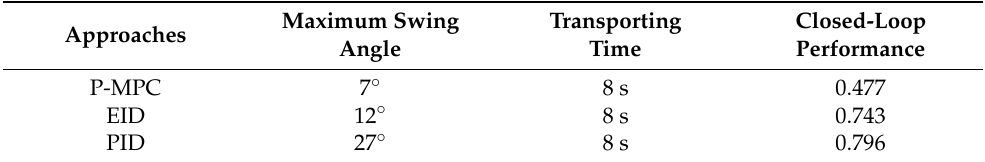
Table 2. The Comparison of the Three Approaches for Case 2.